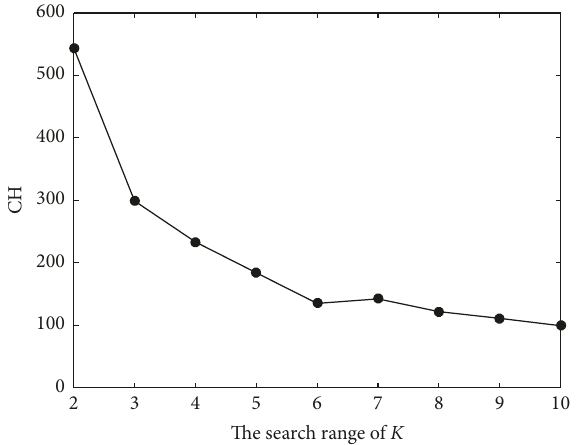
Figure 11: CH value for different clustering numbers.